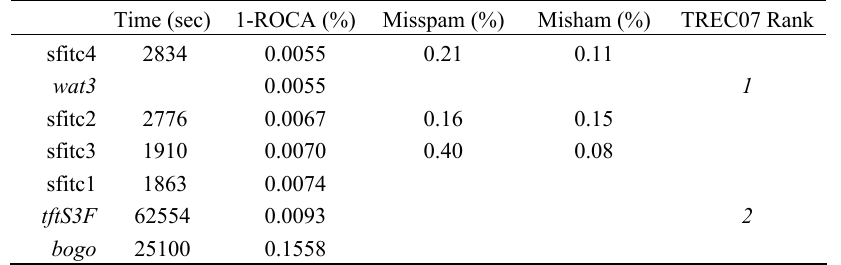
Table 4. Experimental Results: Time, 1-ROCA, Misspam, Misham Performance and TREC07